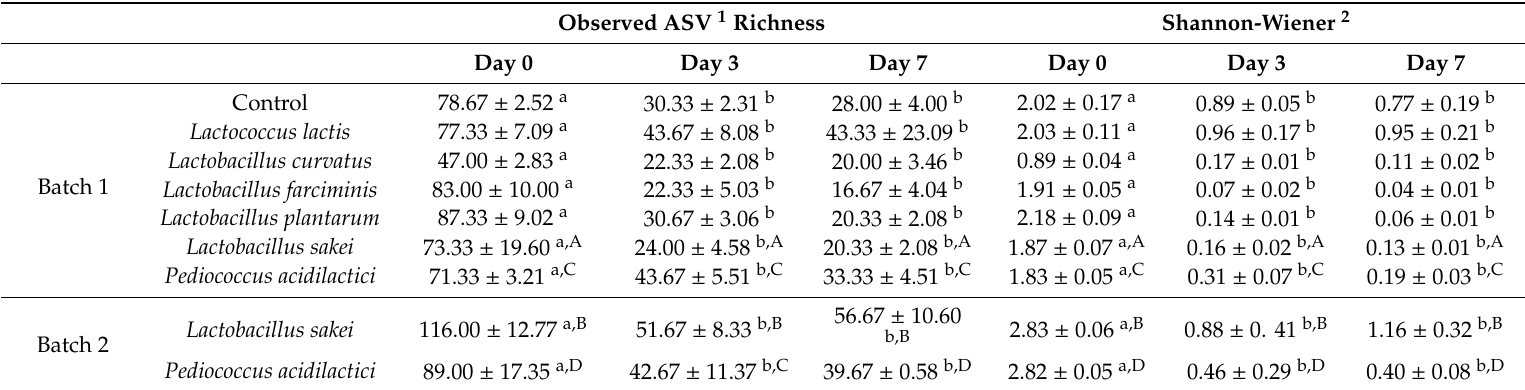
Table A1. (Supporting Information). Microbial community diversity indices of fermented mealworm paste subjected to metagenetic analysis (with the addition of sodium nitrite).